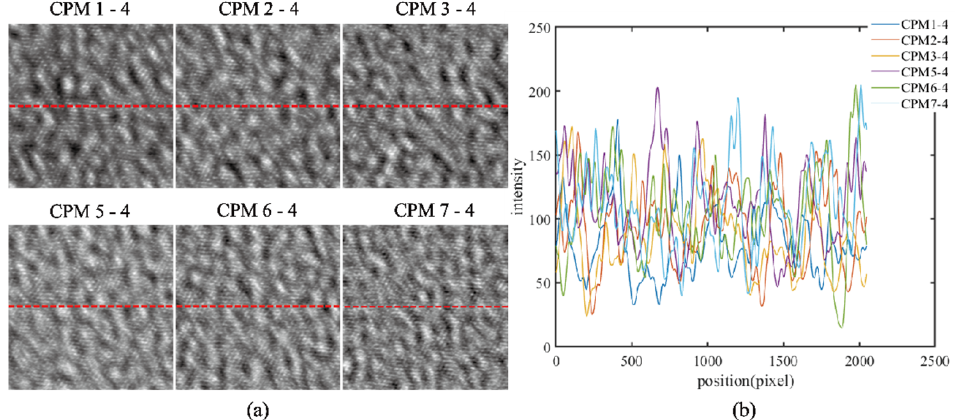
Figure 2. Analysis of the similarity of speckle images modulated by different CPMs. ( a ) The cross ‐ correlation with CPM4; ( b ) Profiles of the red dashed lines in ( a ).